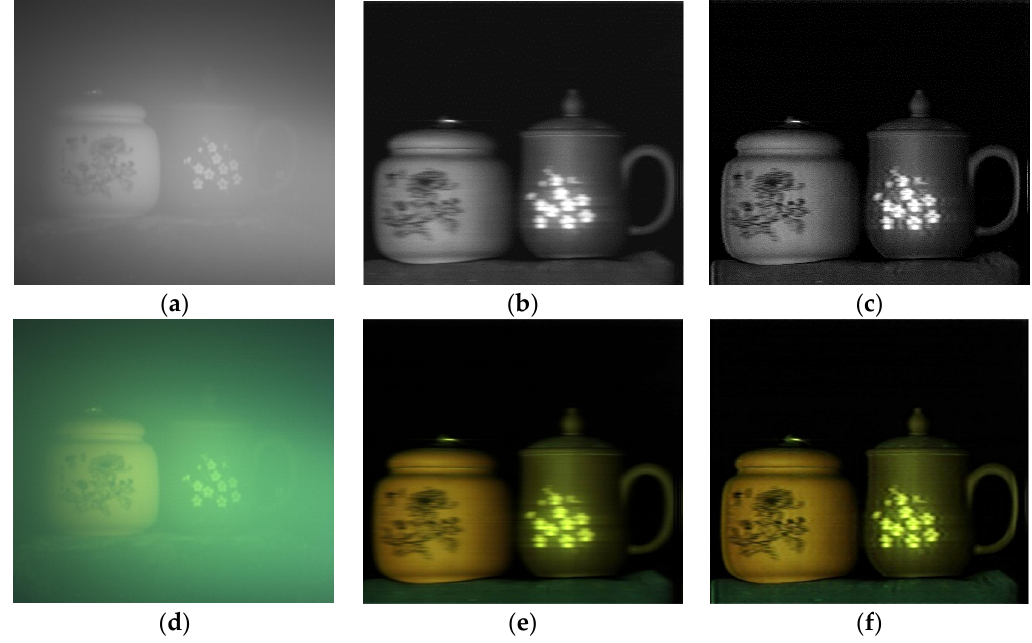
Figure 7. Experimental results of image recovery with light turbidity of water. ( a ) Floodlit gray level image; ( b ) Synthesized image after the removal of back scattered light; ( c ) Result of blind deconvolution using the Lucy–Richardson (L–R) method; ( d )–( f ) Colored versions associated with the same implementations as of (a)–(c) with respect to RGB channels, respectively.